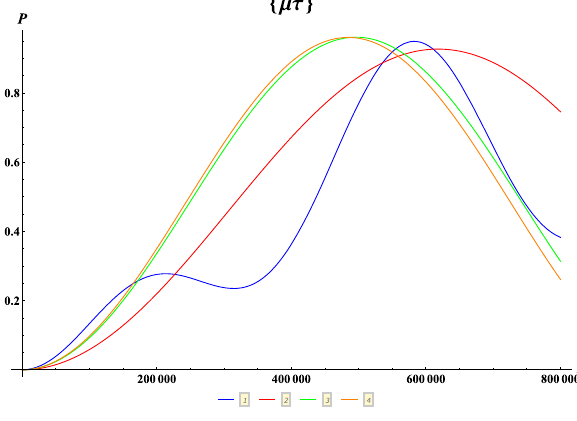
Fig. 11 Same analysis of Fig. 10, but for the case of P ν μ ,ν τ